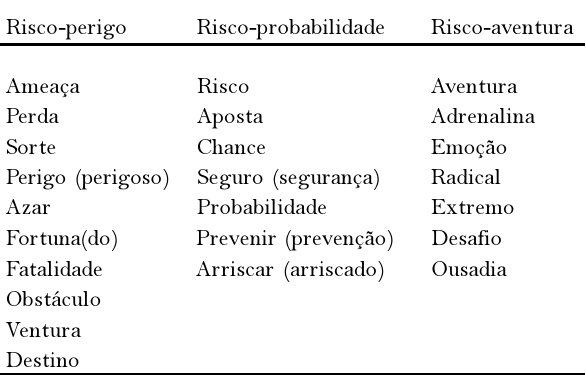
Figura 1. Os glossários do